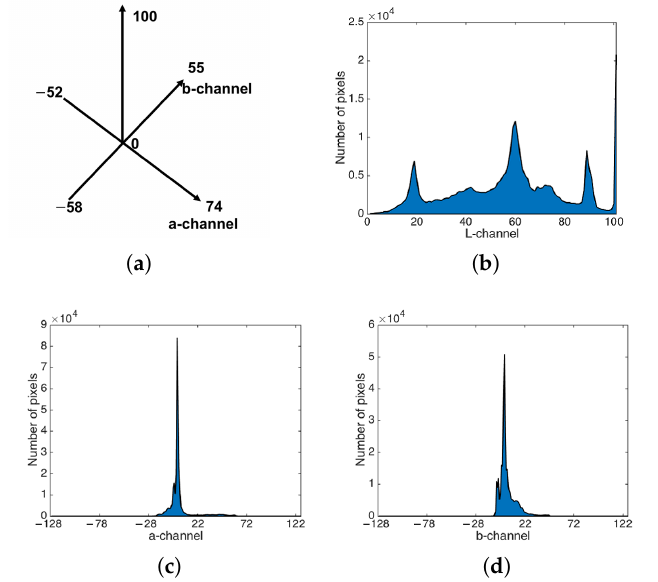
Figure 1. Example of TCS in Girl2 dataset. ( a ) Total color space. ( b ) Color distribution in L-channel. ( c ) Color distribution in a-channel. ( d ) Color distribution in